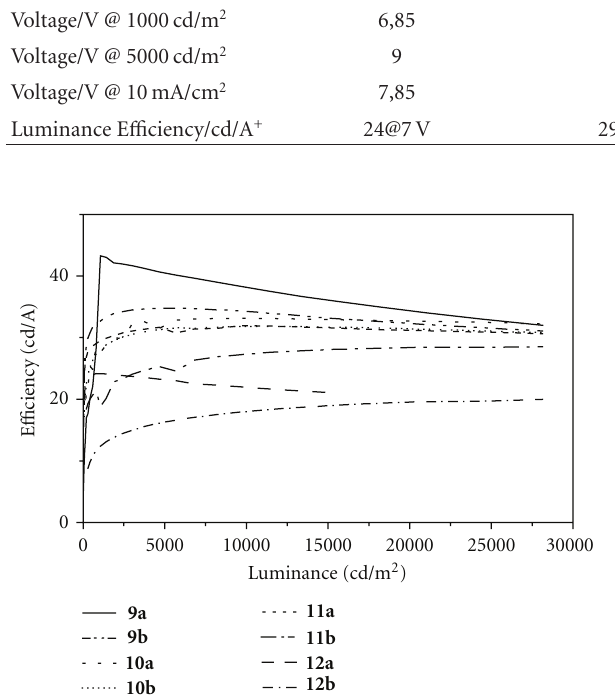
Figure 15: Current e ffi ciency-luminance plot of OLEDs depending on the used electron-transporting polymers 9a/b – 12a/b